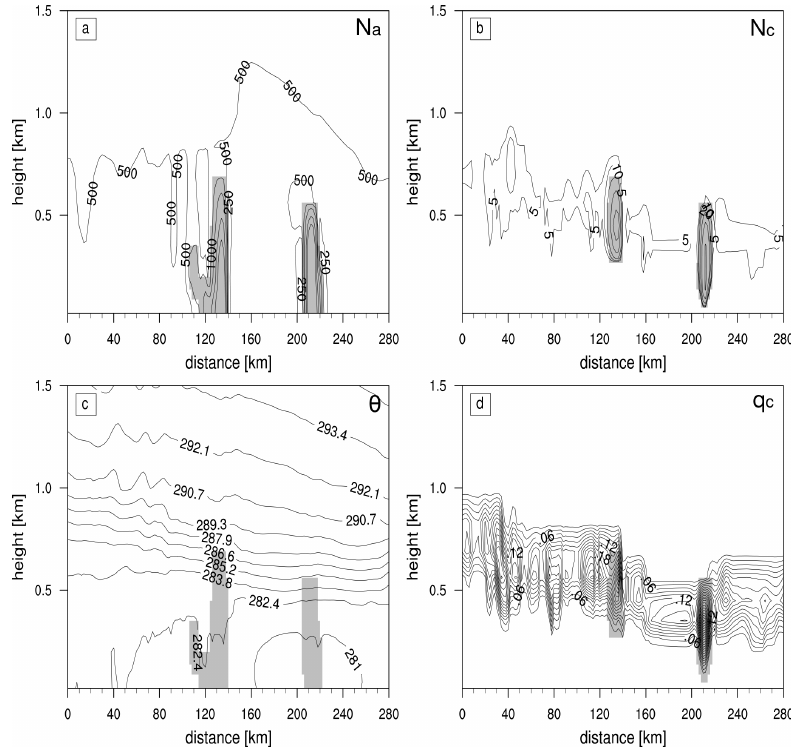
Figure 8. Vertical cross-sections (location shown in Fig. 6 row c ) for (a) the total aerosol number concentration N a [cm − 3 ], (b) N c [cm − 3 ], (c) θ [K] and (d) the liquid cloud water content q c [gkg − 1 ]. Each contour in (a) indicates a doubling of the concentration starting at 250cm − 3 . In (b) the contour levels are: 2, 5, 10, 50,... every 50...,350cm − 3 . θ contours are given at an interval of 1 . 4K and for q c the contour spacing is 0.02gkg − 1 . Grey shading in (a, c) indicates plume points and in (b, d) plume points where a significant cloud response was simulated as defined in Sect. 2.3.